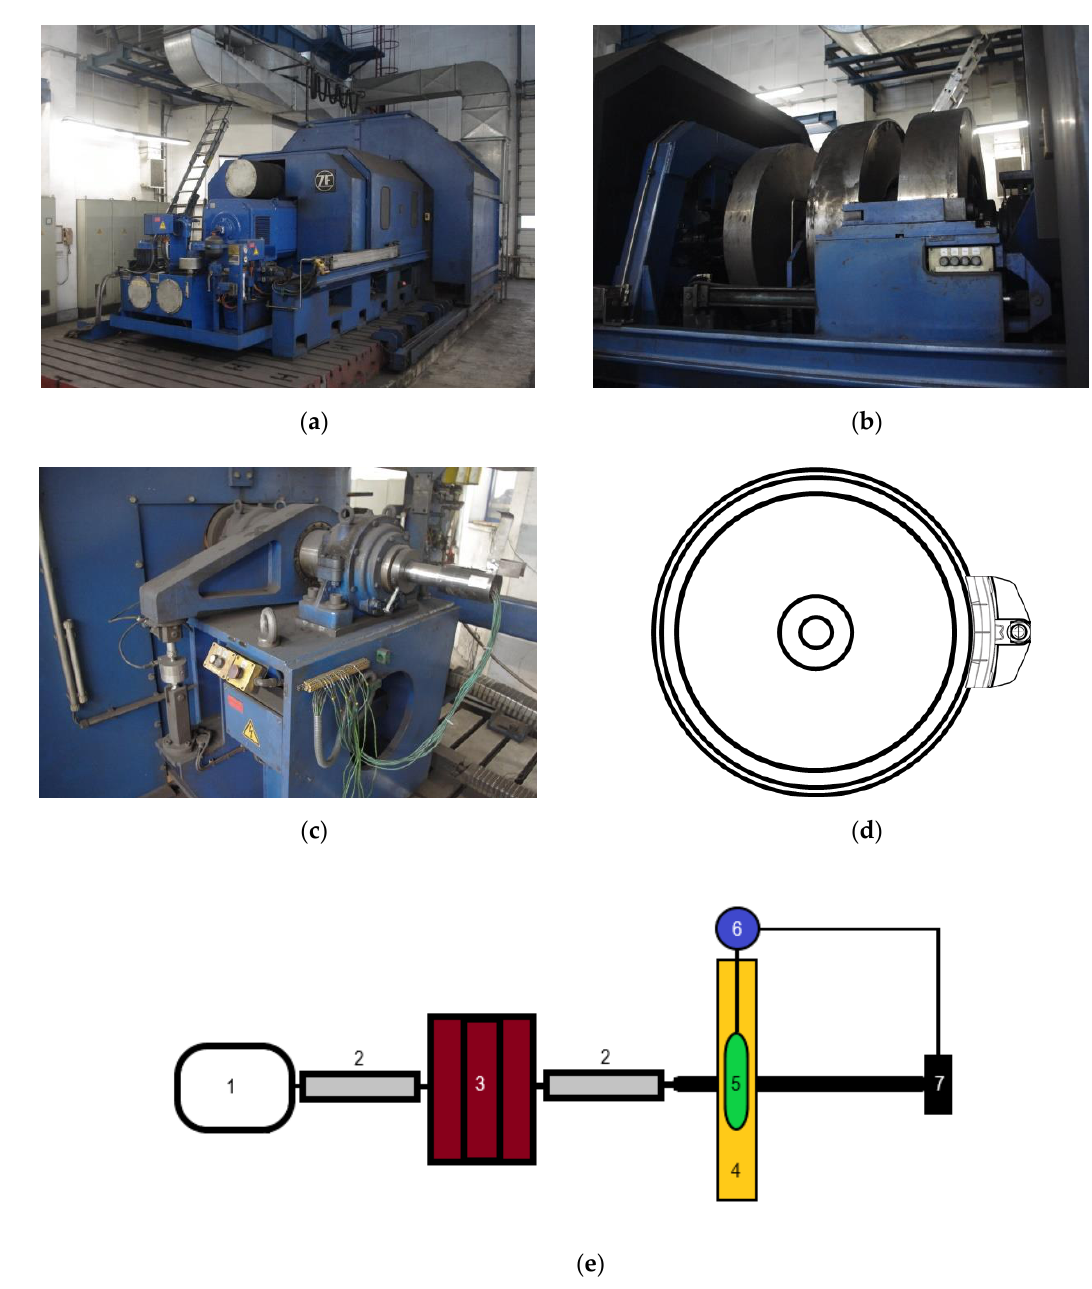
Figure 1. A full-scale inertia dynamometer for testing of brake friction pairs at the Railway Research Institute in Warsaw ( a – c ) (pictures courtesy of the Railway Research Institute in Warsaw) and ( d ) 1xBg railway tread brake configuration, ( e ) scheme of the test rig with main components: 1—electric motor; 2—drive shaft; 3—flywheels; 4—railway wheel; 5—brake block; 6—brake cylinder; 7—load cell.